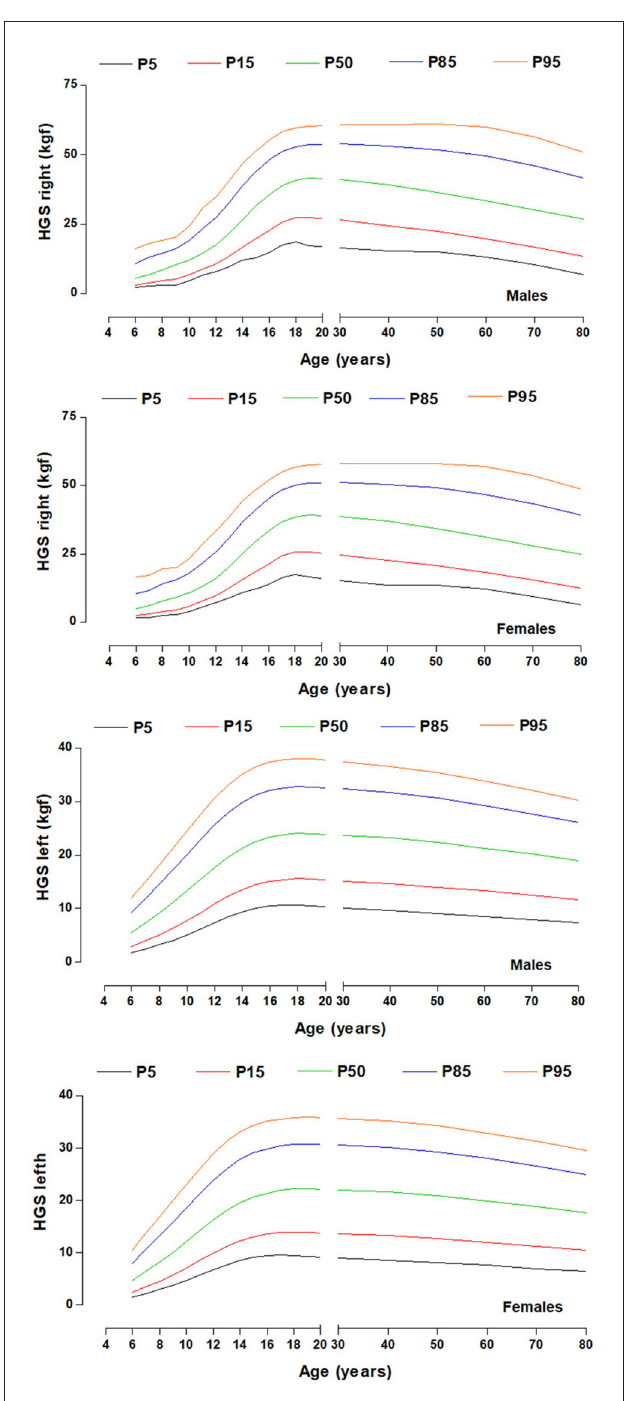
FIGURE2 HGS percentiles by chronological age for both sexes and both hands.